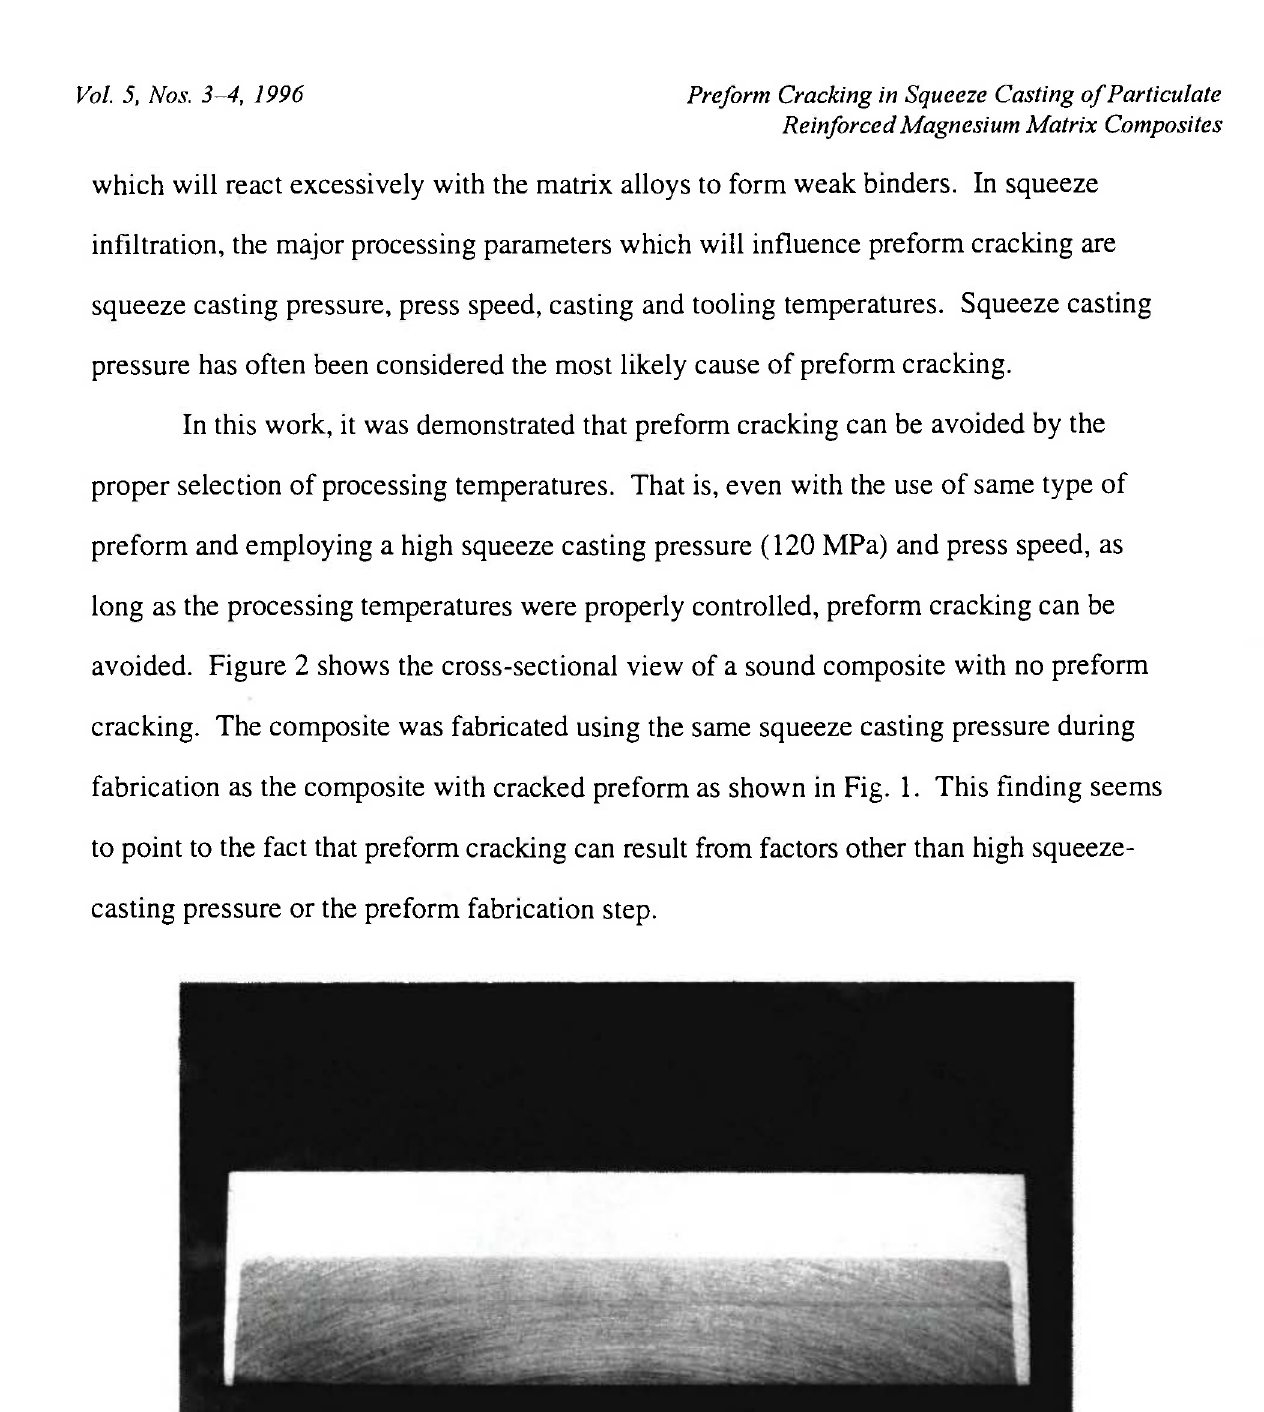
Figure 2. Cross-sectional view of a SiC particulate reinforced AZ91D magnesium-based composites with uncracked preforms. Sample was squeeze cast at 120